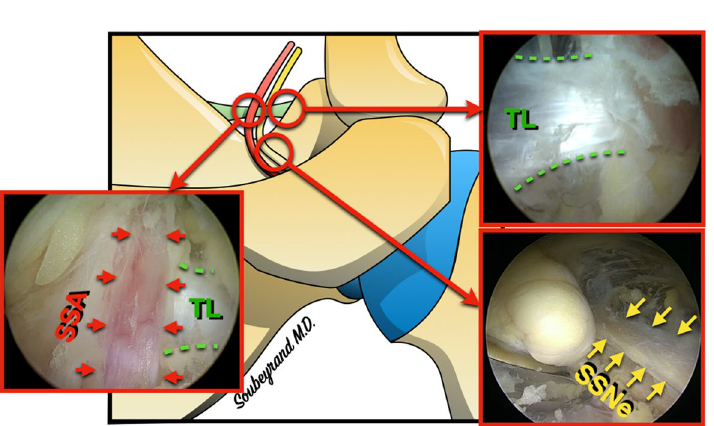
Figure 6. Arthroscopic aspect of the suprascapular notch (SSNo) with the suprascapular nerve (SSNe), suprascapular artery (SSA) and superior transverse scapular ligament (TL).